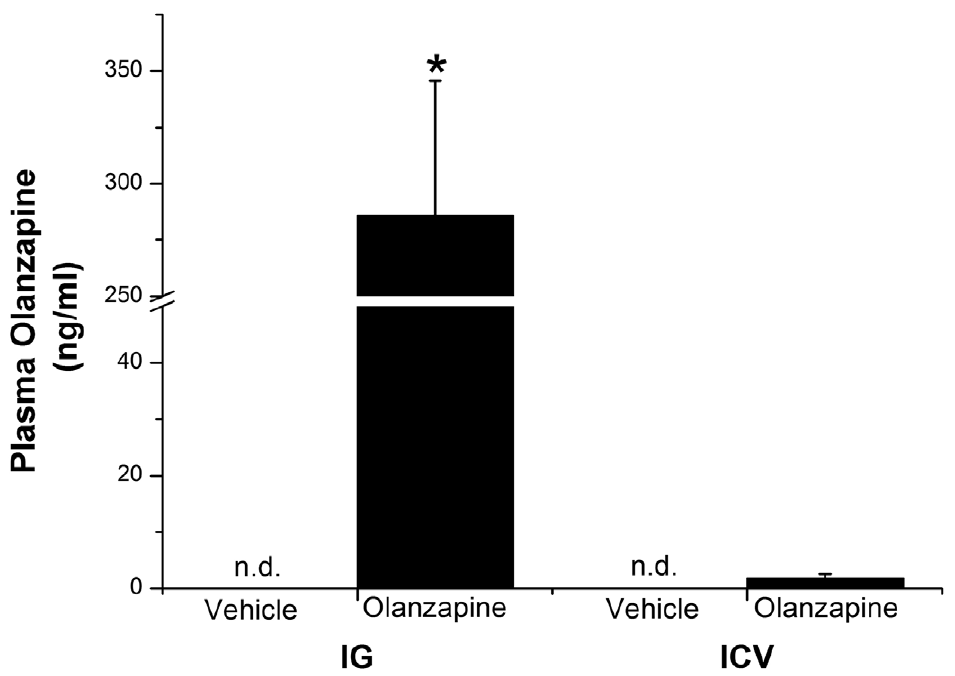
Figure 3. Plasma Olanzapine levels after intragastric (IG) and intracerebroventricular (ICV) infusion of Olanzapine. (IG: Vehicle group n=5, Olanzapine group n=6 and ICV Vehicle group n=8 and Olanzapine group n=12) Plasma Olanzapine levels are significantly higher in IG- Olanzapine-treated than in IG-vehicle-infused animals (One-Way ANOVA, p , 0.001), or ICV-Olanzapine animals (2-Way ANOVA, Administration route * Treatment p , 0.001). Plasma Olanzapine levels of ICV-Olanzapine animals are not significantly different from the ICV-Vehicle animals (One-Way ANOVA, p=0.2). Vehicle-treated animals = white bars; Olanzapine-treated animals = black bars; *p , 0.001.